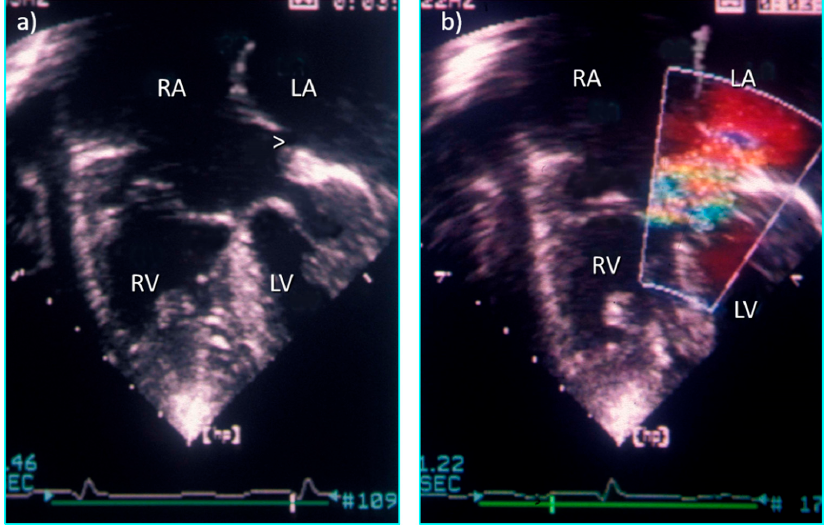
Figure 15. Four chamber echocardiographic sections from a heart with double outlet right atrium and restrictive primum defect (ASD) ( a ) without colour flow Doppler and ( b ) with turbulence across the restrictive ASD.